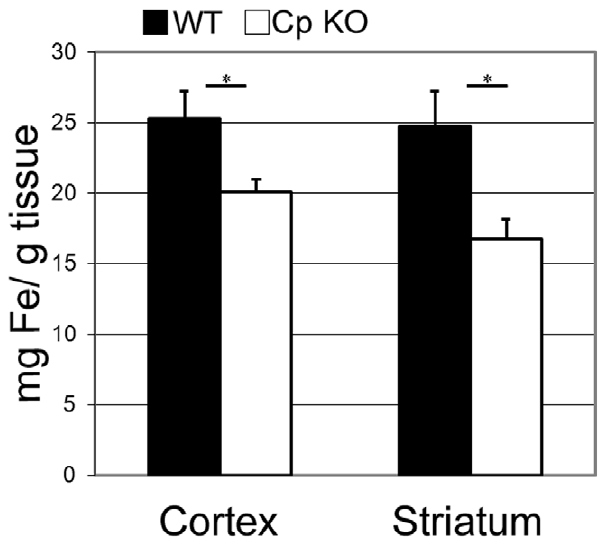
Figure 1. CpKO mice have decreased concentrations of iron in the cerebral cortex and striatum. Atomic absorption measures of cortical and striatal biopsy punches show significant decreases in iron concentrations in CpKO compared to wild type mice in both the cerebral cortex ( n=18; *p , 0.02) and the striatum (n=7; *p , 0.03).